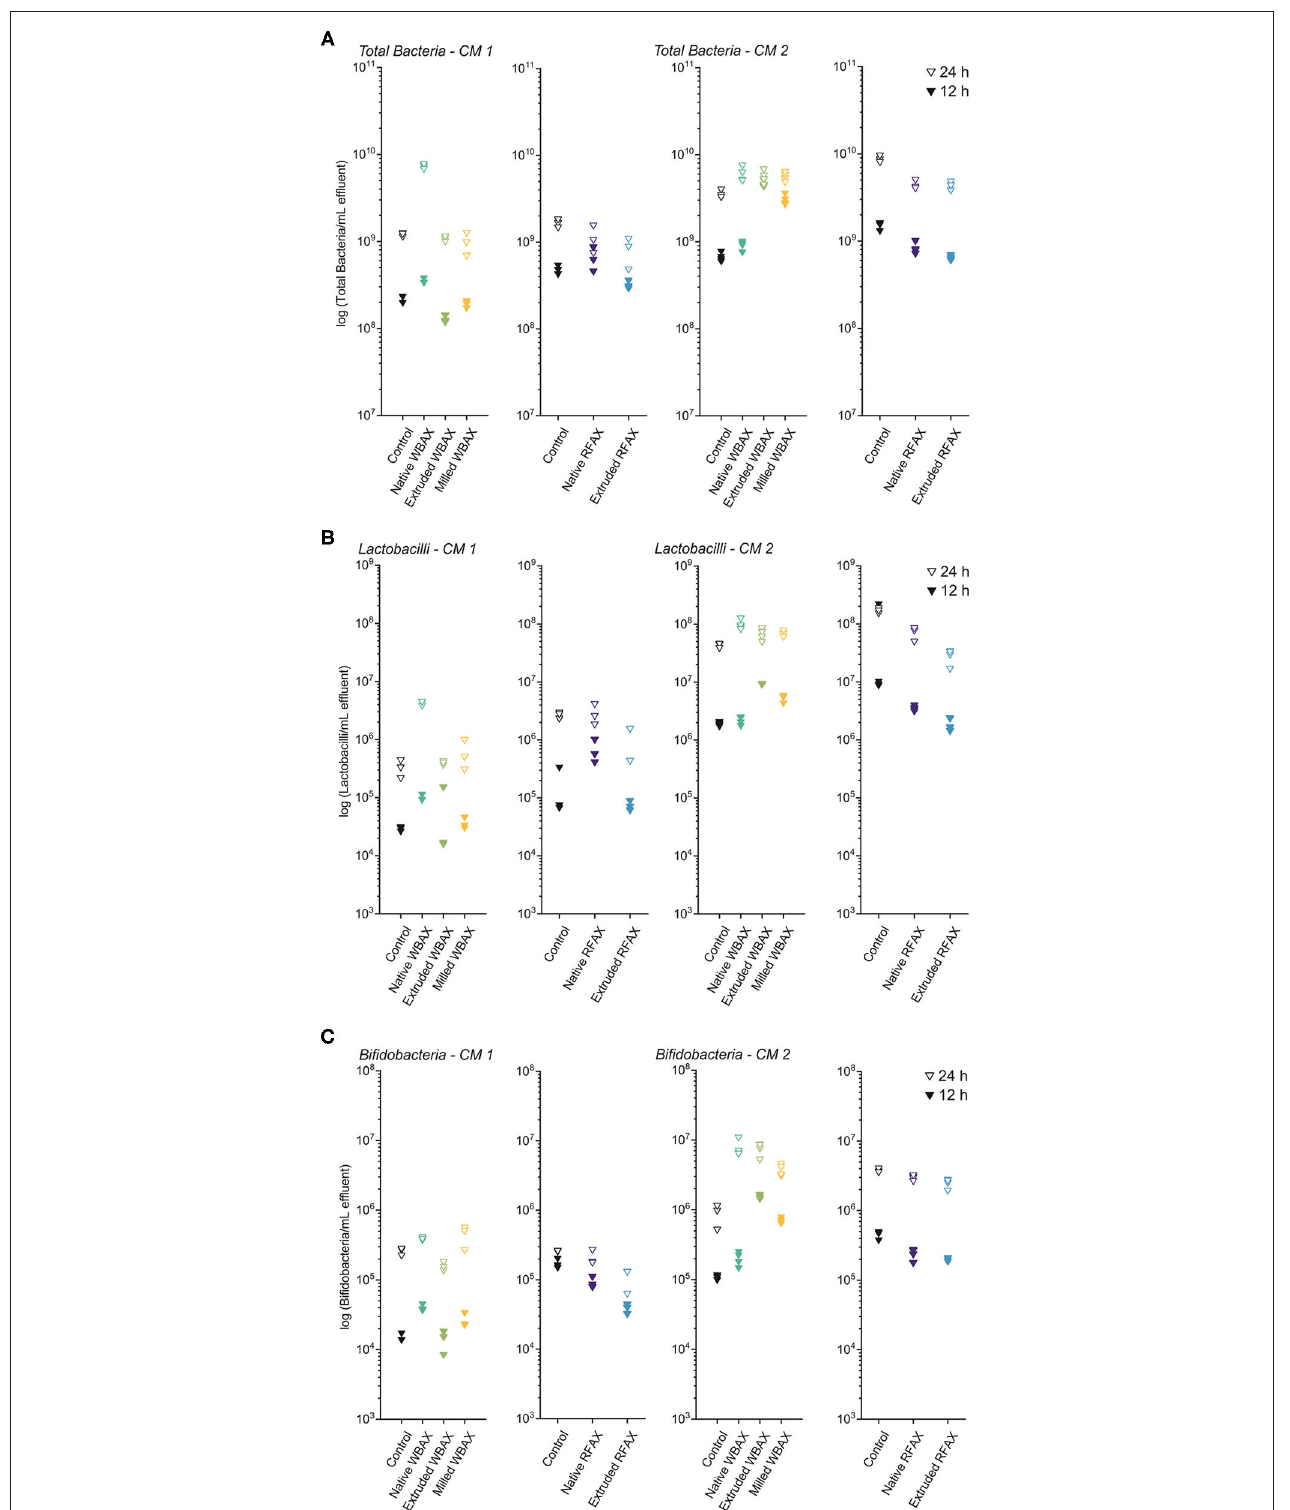
FIGURE 7 | Bacterial quantification by quantitative PCR targeting total bacteria (A) , Lactobacillus/Leuconostoc/Pediococcus spp. ( LLP ) (B) , and Bifidobacterium spp. (C) at 12 and 24 h of in vitro colon fermentation of differently processed WBAX and RFAX by two CM 1 and CM 2.